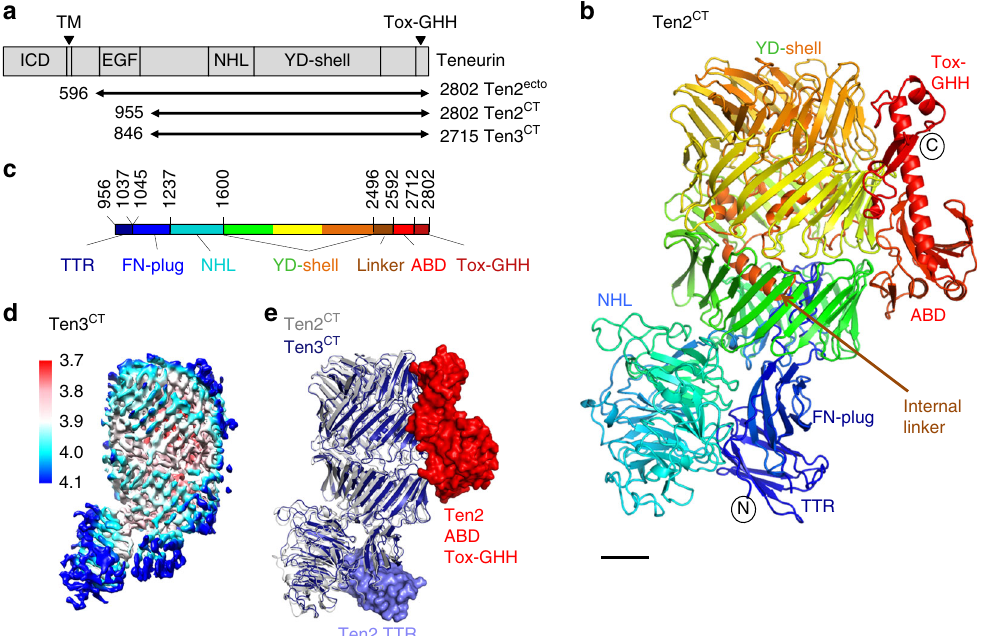
Fig. 1 The Teneurin family super-fold. a Overview of Teneurin constructs used in biophysical and functional analysis. The predicted domain organisation of Teneurins based on the literature is shown alongside. b The 2.4 Å crystal structure of Ten2 CT is shown in ribbon representation and rainbow-coloured (blue, N terminus; red, C terminus). The position of each sub-domain is indicated. Scale bar = 1 nm. c The crystal structure was used to derive domain boundaries for each sub-domain in the Ten2 CT primary sequence. Colours are according to the model shown in b . TTR transthyretin-related, FN-plug fi bronectin-plug; NHL NCL, HT2A and Lin-41, YD tyrosine-aspartate, ABD antibiotic-binding domain-like. d The 3.8 Å cryo-EM map of Ten3 CT is shown, coloured according to resolution. Colour key depicts resolution in angstrom. e The models of Ten2 CT (grey) and Ten3 CT (blue) are superposed and shown in ribbon representation. The TTR, ABD and Tox-GHH domains are disordered in the cryo-EM model of Ten3, and are shown in surface representation